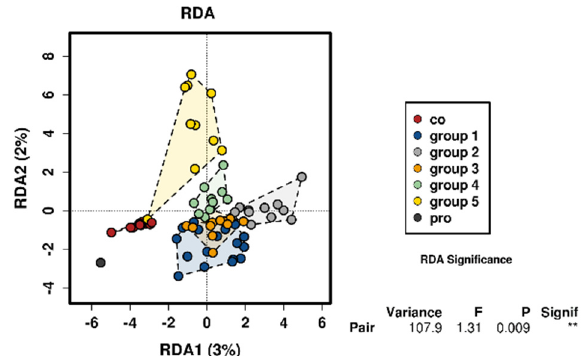
Figure 7. RDA plot of di ff erent age groups (Group 1,18–27 years; Group 2, 28–37 years; Group 3, 38–47 years; Group 4, 48–57 years; and Group 5, 58–70 years). “Co” (red) are the controls and “pro” (black) the product control. The figure shows that age Groups 1–4 are clustering, whereas Group 5 is separate. The controls are clustered together, and the product control is di ff erent from the other samples. The overlapping of controls with Group 5 samples indicates samples with a low number of reads.